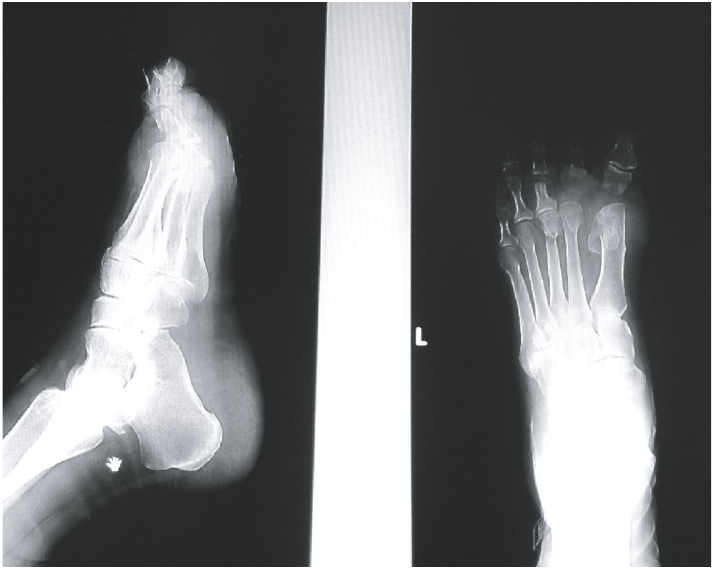
Figure 3: X-ray of the patient ’ s left foot at the fi rst postoperative